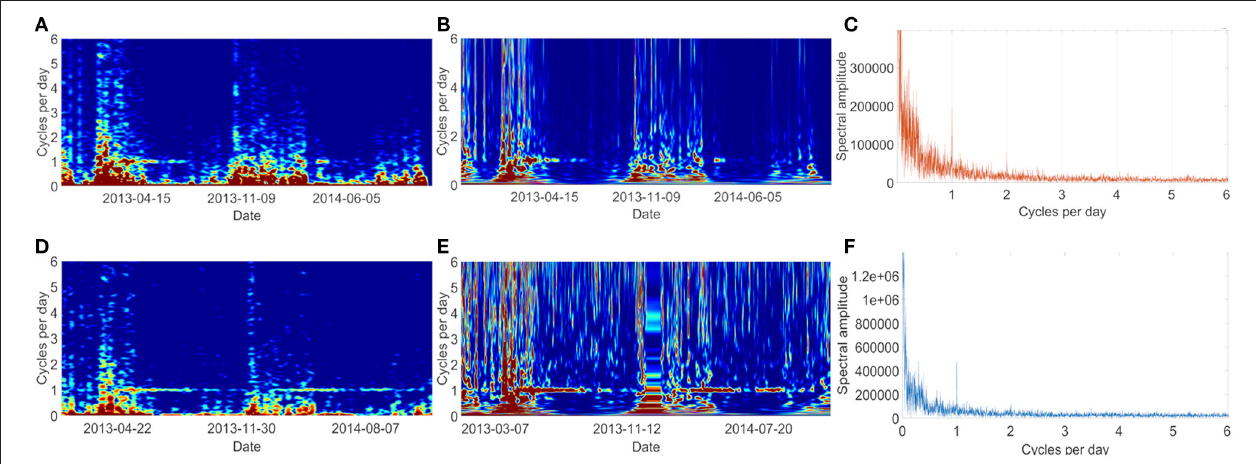
FIGURE 5 | Spectral results for the observed and residuals soil CO 2 fluxes for the period 2013–2014: (A) s pectrogram, (B) scalogram and (C) FFT spectrum of the observed values; (D) spectrogram, (E) scalogram (F) and FFT spectrum of the residuals.